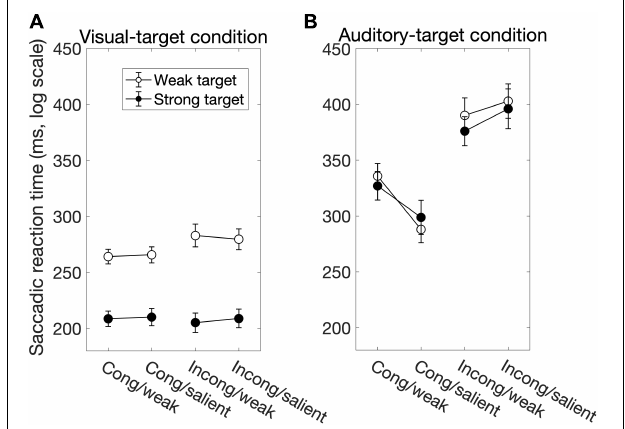
FIGURE 2 | The factors influencing the saccadic reaction time (SRT) for the visual-target condition (A) and for the auditory-target condition (B) . White and black circles indicate the weak and strong targets, respectively. The error bars represent the standard error of the mean. For the statistical comparison of the factors, see Tables 1 , 3 . Generally, the saccade behavior depended on task modalities.